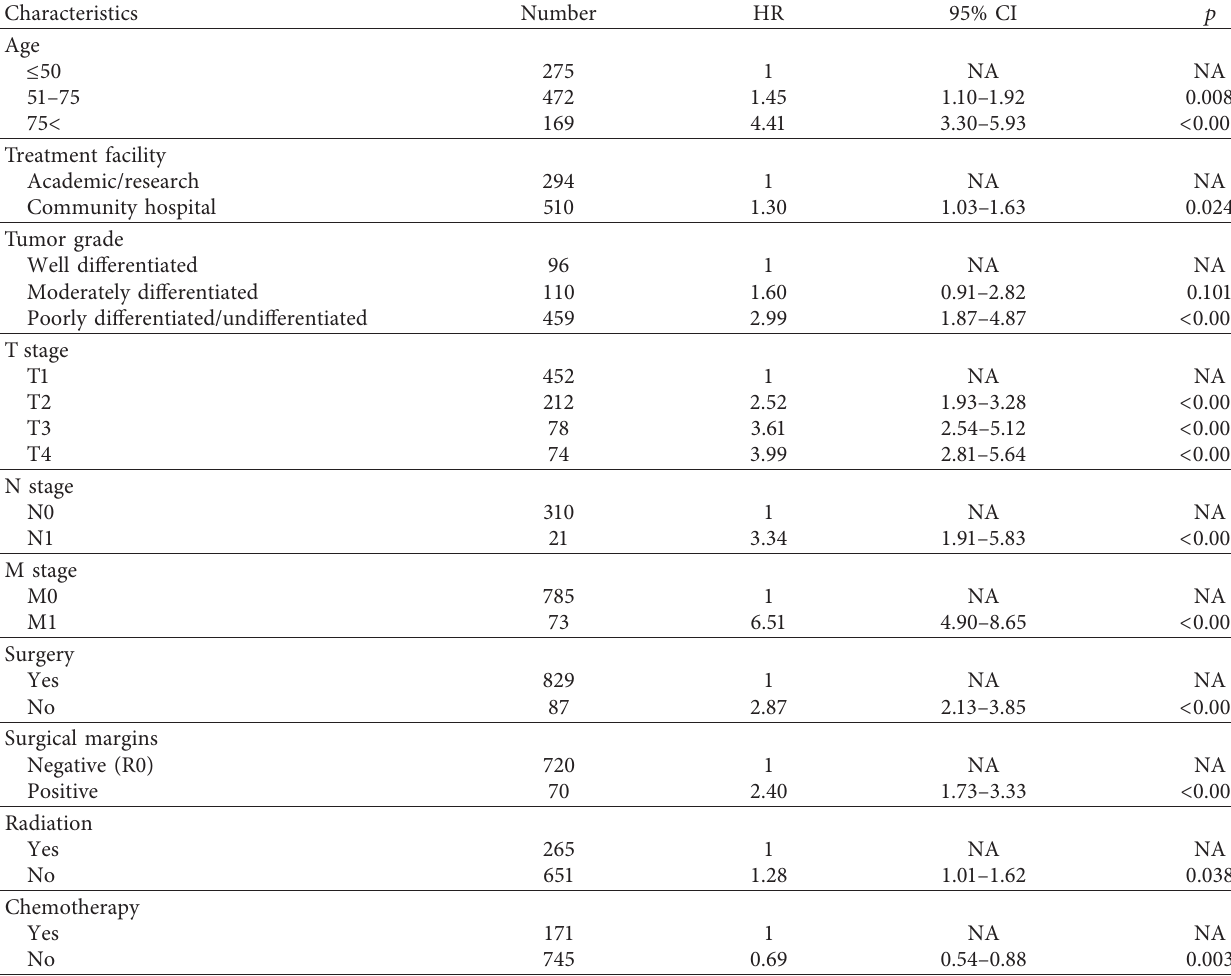
Table 6: Overall survival associated with clinicopathologic characteristics, the Cox proportional hazard